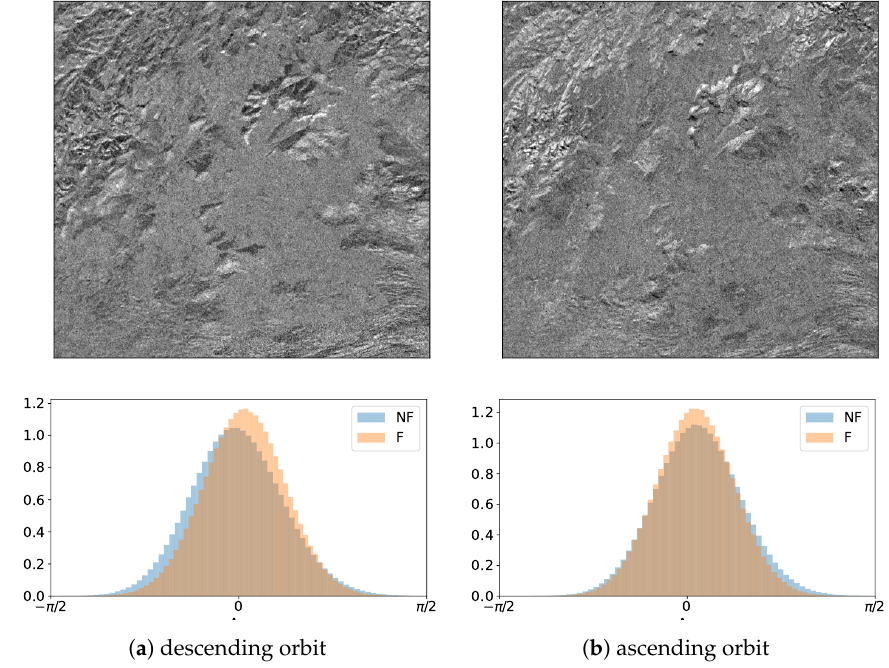
Figure 9. This figure shows the distribution of the VV-VH phase difference ( ∆ ϕ ) in descending ( a ) and ascending orbit ( b ) for the UK study site. The top row shows the phase difference for each pixel, while the bottom row shows the corresponding distribution separately for forest and